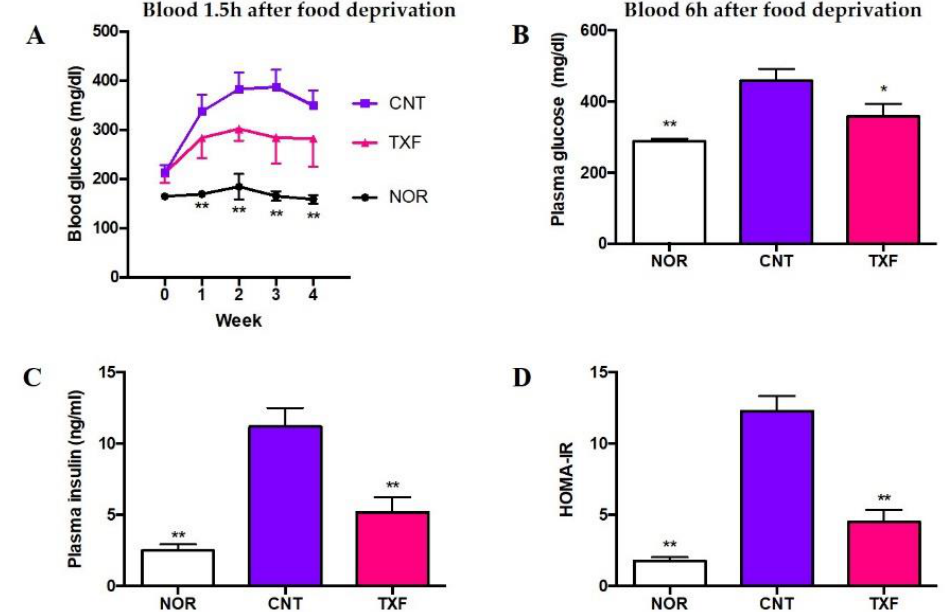
Figure 4. Effect of taxifolin on time-dependent changes in blood glucose levels ( A ), and on fasting plasma glucose ( B ), insulin ( C ), and HOMA-IR ( D ) levels in T2D model KK-A y /Ta mice. Changes in blood glucose levels after 1.5 h fasting were measured every week for 4 weeks ( A ). At the end of the experimental period of four weeks, mice were fasted for 6 h, whole blood was collected from each mouse, and plasma sample was prepared. Then, plasma glucose ( B ) and insulin ( C ) levels were determined, and finally HOMA-IR ( D ) was calculated. Each value represents the mean ± SEM for eight (Nondiabetic Normal; NOR), seven (Diabetic Control; CNT), or six (Diabetic Taxifolin-treated; TXF) mice. * , ** Significantly different from the CNT group at * p < 0.05 and ** p < 0.01, respectively, by Dunnett multiple comparisons